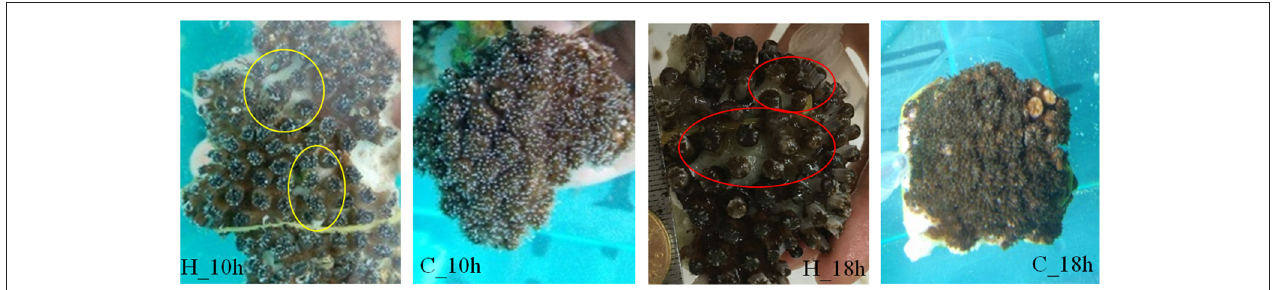
FIGURE 1 | Bleaching and lysing in G. fascicularis during heat stress treatment. No apparent bleaching and lysing were observed in control groups (C_10h and C_18h), while in group H_10h (10h after heat stress treatment), some phenomena of bleaching and lysing initiation began to appear, the cup edges of a few polyps and the coenosarcs turned white (yellow ellipse). As the heat stress continued, in group H_18h (18h after heat stress treatment), the coenosarcs became lysed and degraded and the tentacles were dissolved into dark brown mucus (red ellipse).